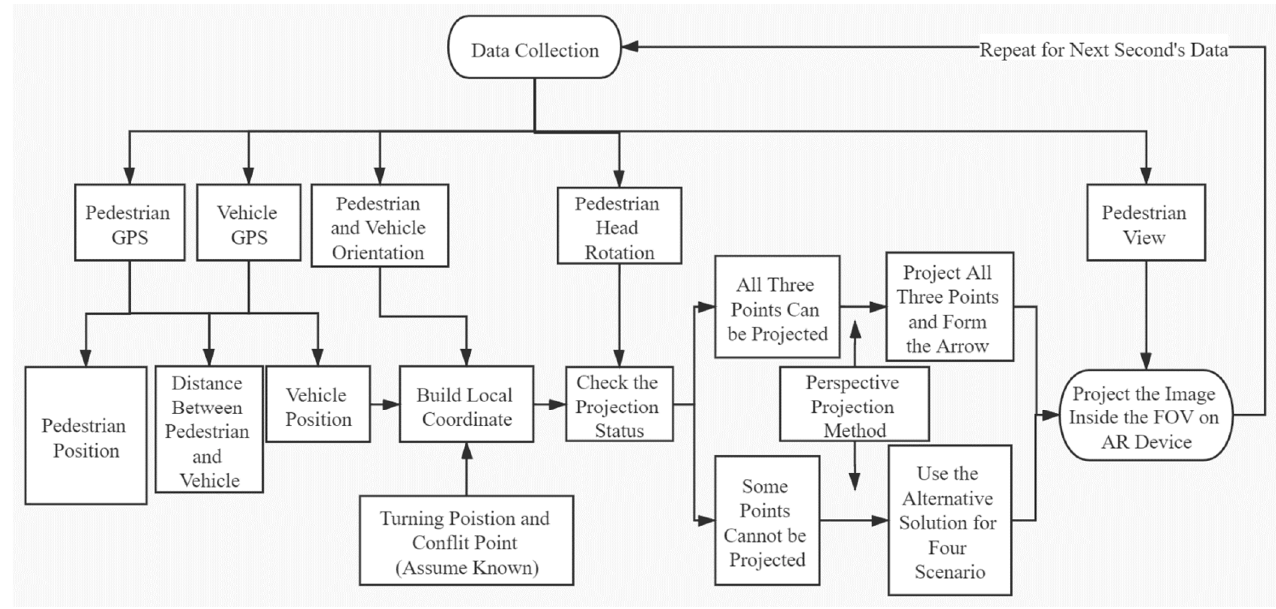
Figure 1. Warning system summary.